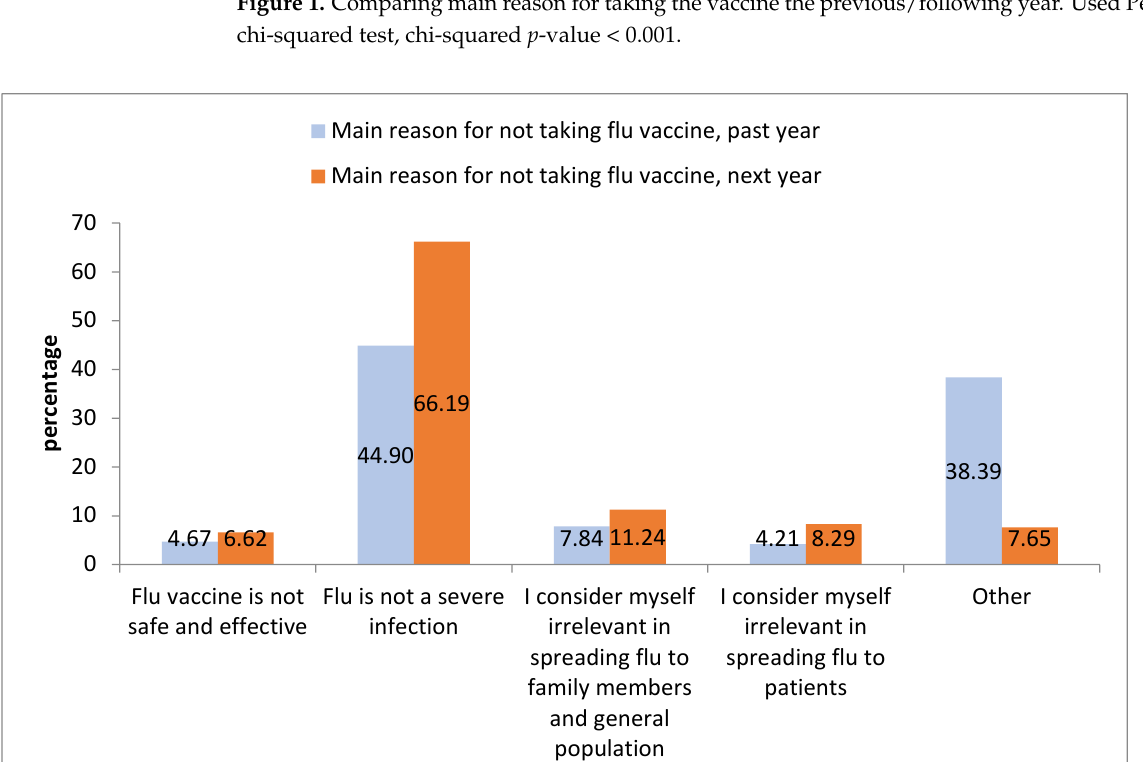
Figure 1. Comparing main reason for taking the vaccine the previous/following year. Used Pear- son’s chi-squared test, chi-squared p -value < 0.001.